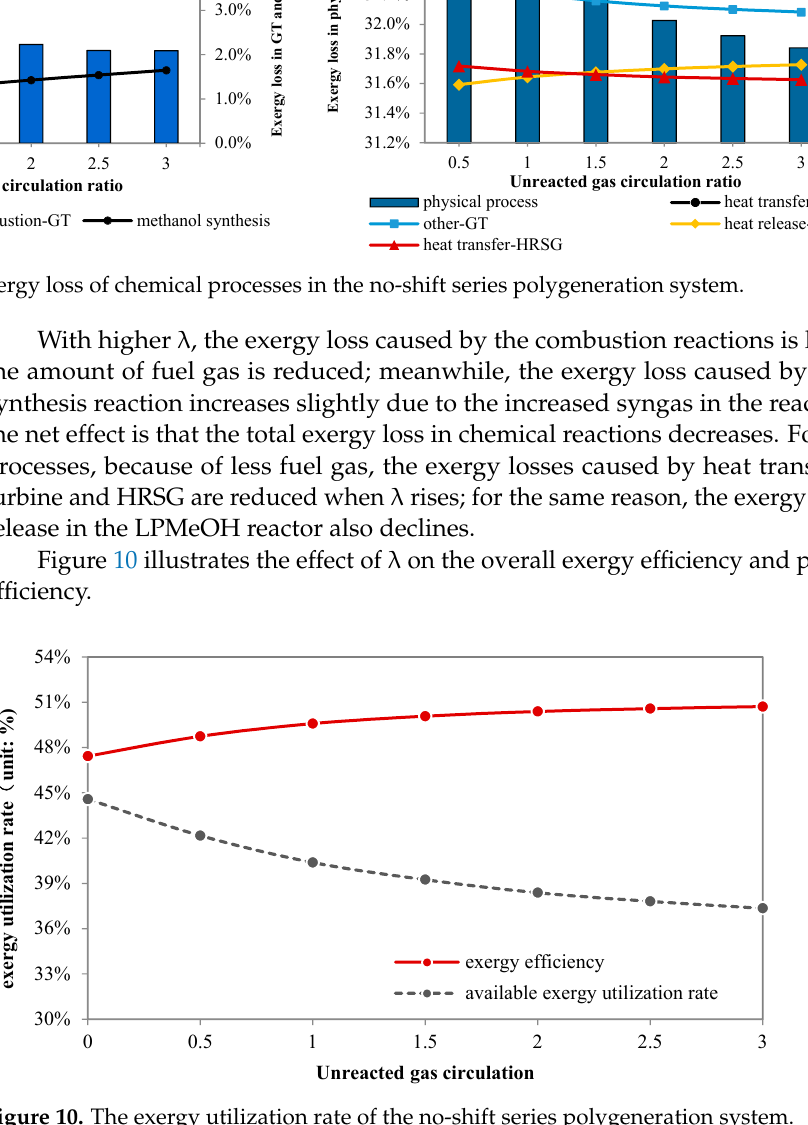
Figure 10. The exergy utilization rate of the no-shift series polygeneration system.